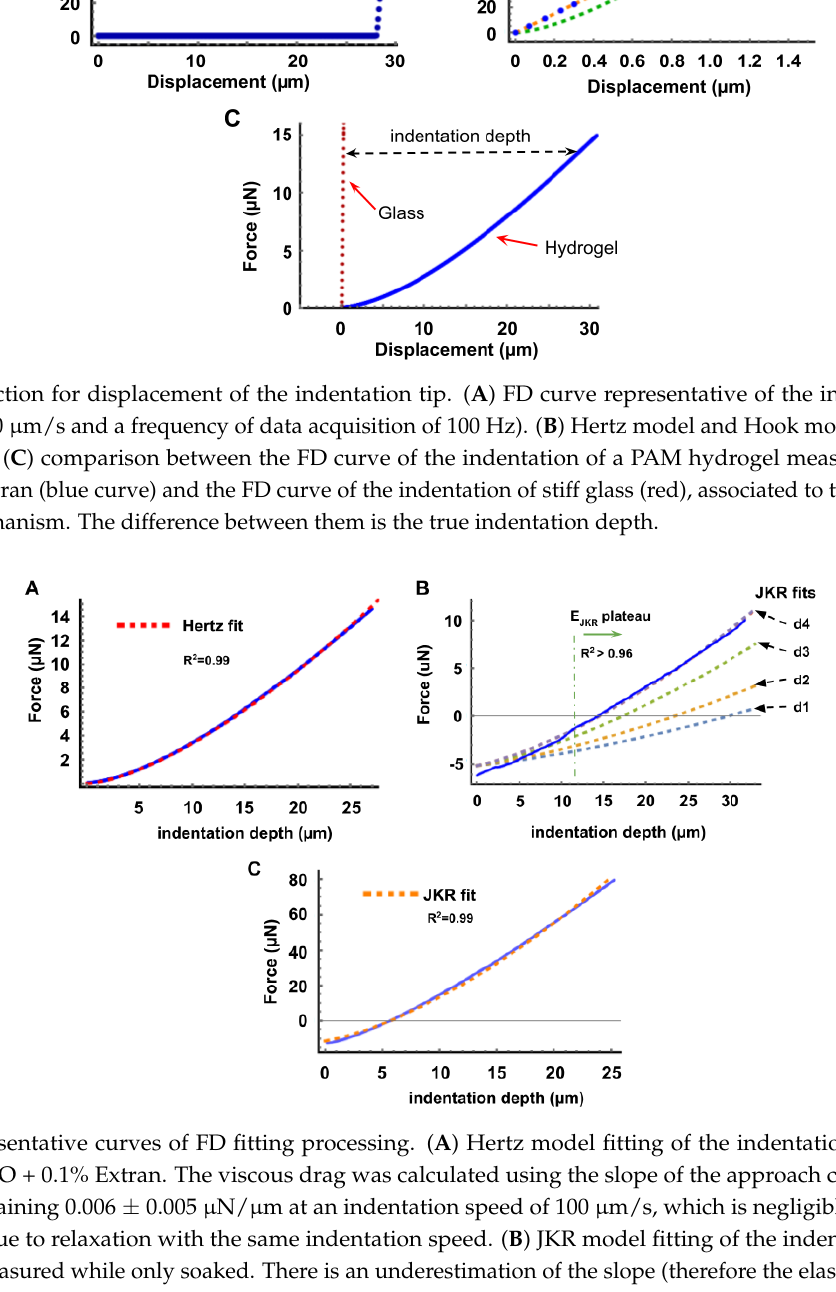
Figure A3. Representative curves of FD fitting processing. ( A ) Hertz model fitting of the indentation of a 4 kPa PAM hydrogel in ddH 2 O + 0.1% Extran. The viscous drag was calculated using the slope of the approach curve (Figure 2C in the main text) obtaining 0.006 ± 0.005 µN/µm at an indentation speed of 100 µm/s, which is negligible compared to the ~0.3 µN change due to relaxation with the same indentation speed. ( B ) JKR model fitting of the indentation of the same hydrogel PAM measured while only soaked. There is an underestimation of the slope (therefore the elastic modulus) when modelling data with distances lower than ~10 µm. Also, for indentation depths greater than ~11 µm the Young’s modulus reaches a plateau value which is similar to the behavior presented in Figure 3 in the main text. ( C ) JKR model fitting of a stiffer hydrogel (~35 kPa, see Table 1) when only soaked in deionized water. There is a clear attraction of ~10 µN, twice that of the softer PAM hydrogel (~5 µN), suggesting a possible dependency of the tip attraction with the stiffness of the sample (acrylamide/bisacrylamide proportions).